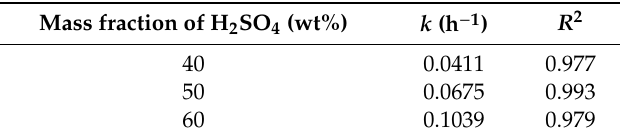
Figure 14. Reaction kinetic function ( a ) Y at different H 2 SO 4 mass fraction; and ( b ) the relationship between ln k and ln c for lithium leaching process. Table 8. Reaction rate constant k and correlation coefficient R 2.